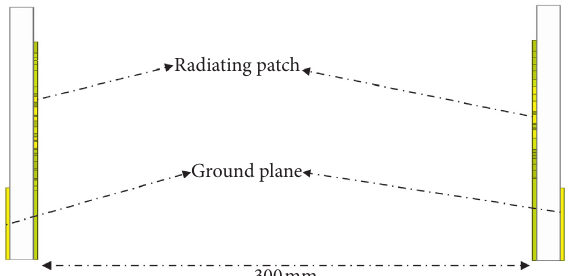
Figure 15: Face-to-face configuration of two VBi-UWBAs.